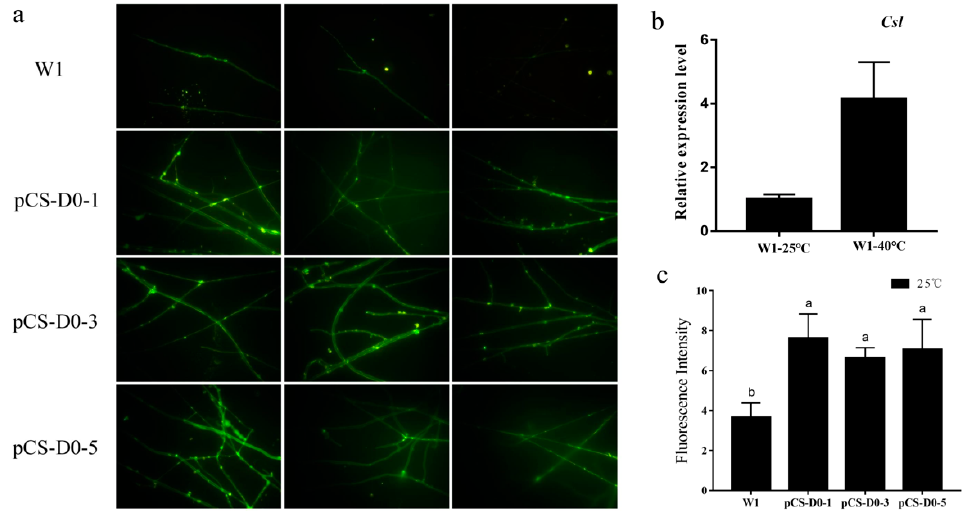
Figure 1. ( a ) Mycelia of pCS-D0 transformants observed with an OLYMPUS BX51 fluorescence microscope compared to wild-type W1; images were taken with a 40 × field of view. ( b ) Relative expression level of Csl before and after heat stress in wild-type W1. ( c ) The fluorescence intensity of pCS-D0 transformants; n = 3, p < 0.01.